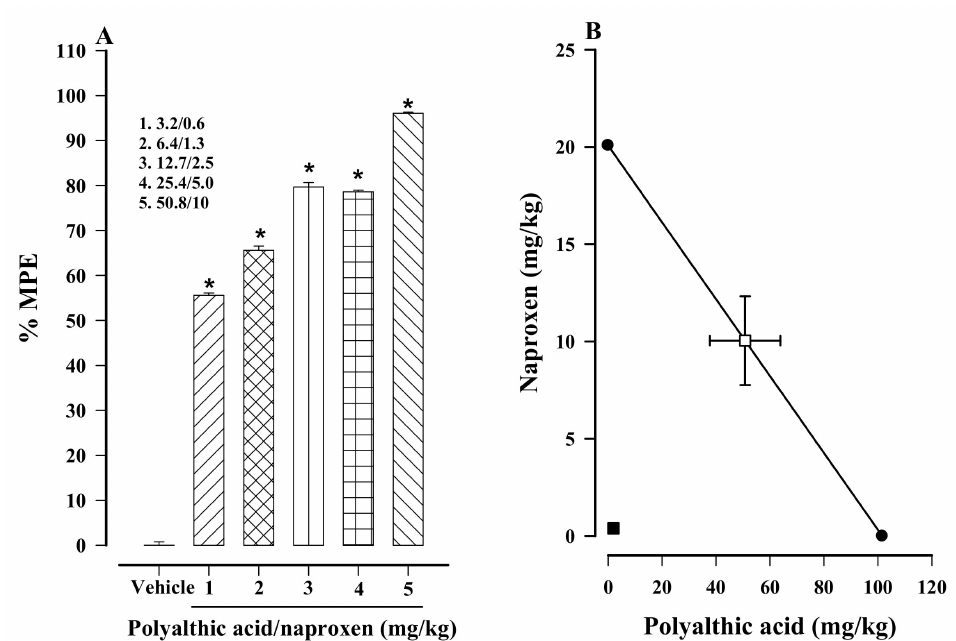
Figure 6. ( A ) Dose-dependent effect resulting from administering each of the five doses of the combi- nation treatment on carrageenan-induced hyperalgesia in rats. Data are expressed as a percentage of activity against hyperalgesia, considering the maximum possible effect (% MPE). The effective dose af- fording 50% of the hyperalgesic activity compared to the vehicle-treated control (ED 50 ) was calculated by linear regression. ( B ) Isobolographic portrayal of the interaction of polyalthic acid and naproxen in the combination treatment. Bars represent the mean ± SEM ( n = 6). * p < 0.0001 vs. the vehicle-treated